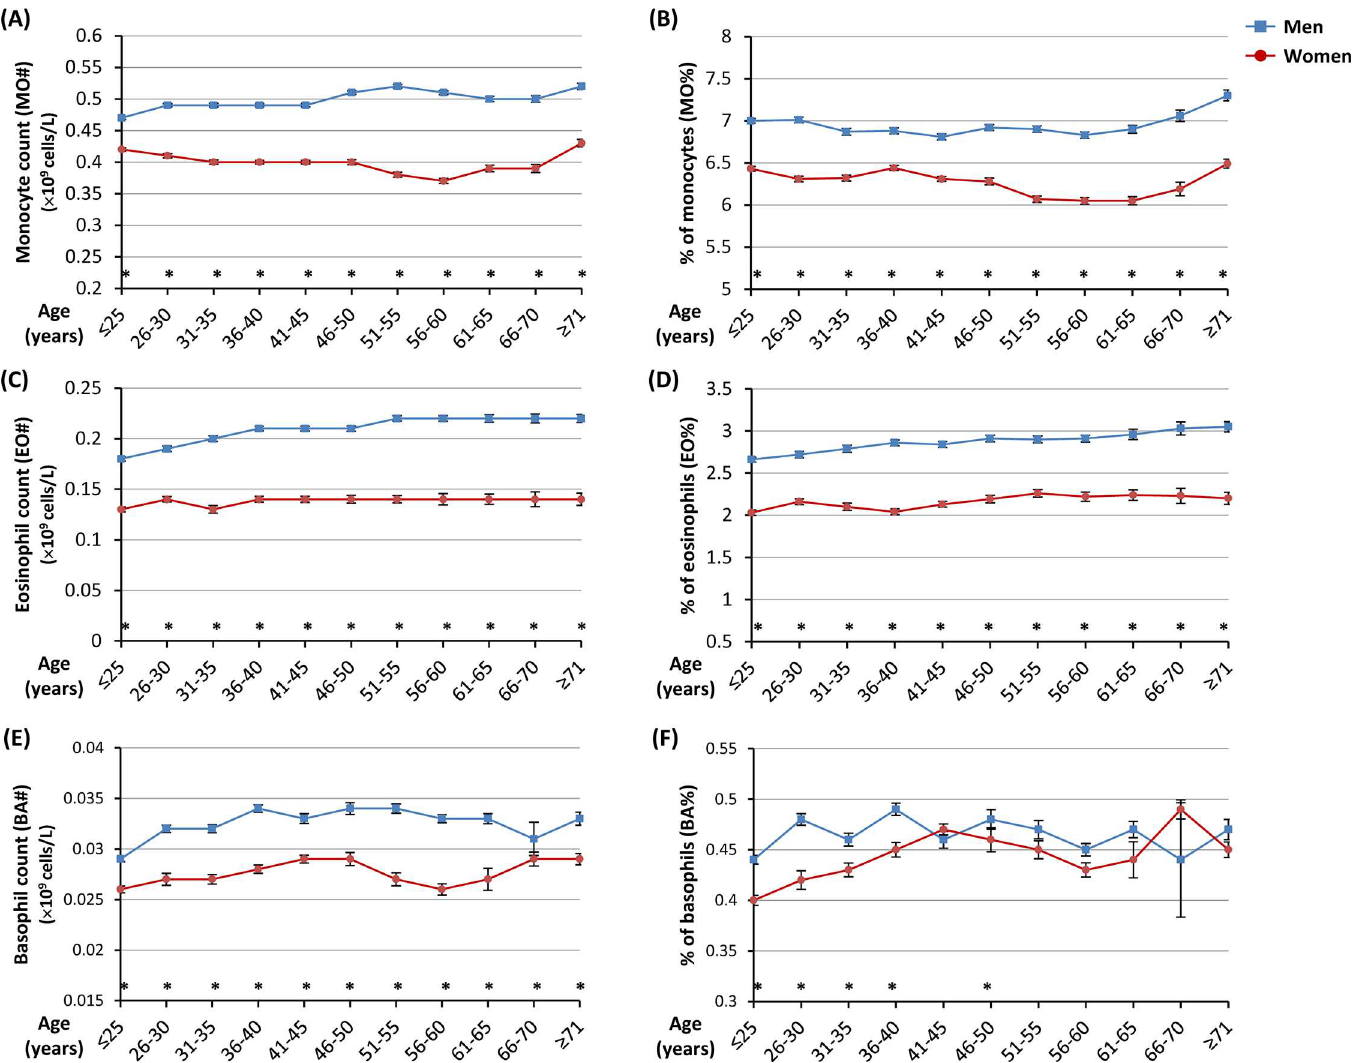
Fig 2. Counts and percentages of monocyte, eosinophil and basophil in men and women in different age groups. Data shown are mean ± standard error of mean in men and women, respectively, in each age group; * indicatesp < 0.05 comparingmen and women in the respective age